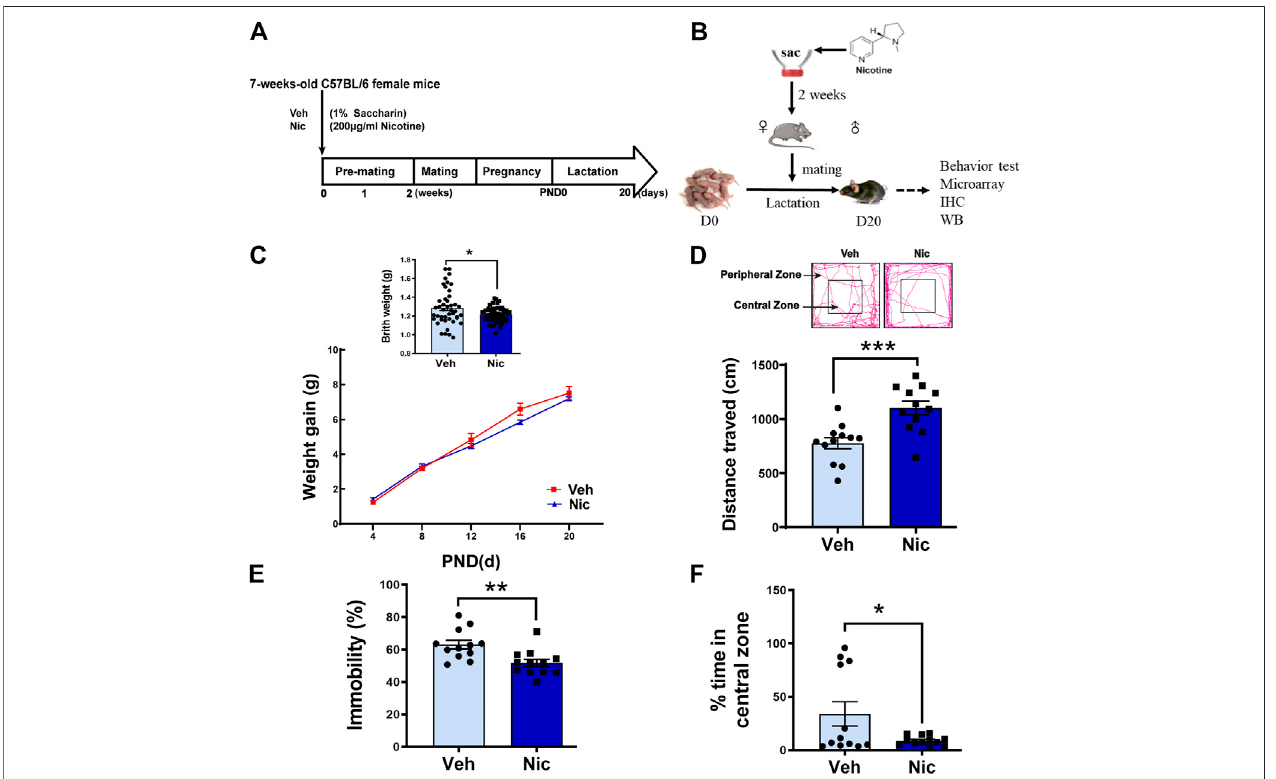
FIGURE1| Maternal nicotine exposure altered the offspring ’ s physical development and exploration behavior. The experimental paradigmofmaternal nicotineexposure (A) andtestsintheoffspring (B) wereshowed.MicewereterminatedonPND20,andbraintissueswerecollectedforfurtherexperimentsafterbehavior tests were completed. (C) Birth weight and body weight gain throughout development were recorded. Open fi eld test revealed that maternal nicotine exposure signi fi cantly increased the total distance traveled (D) of the offspring, but visibly reduced the immobility time (E) , and exploration time in the center zone (F) , as compared to the vehicle control (lower panel). The representative track diagram of open fi eld test was showed (upper panel); * p < 0.05, ** p < 0.01, *** p < 0.001, all data are means ± SEM.